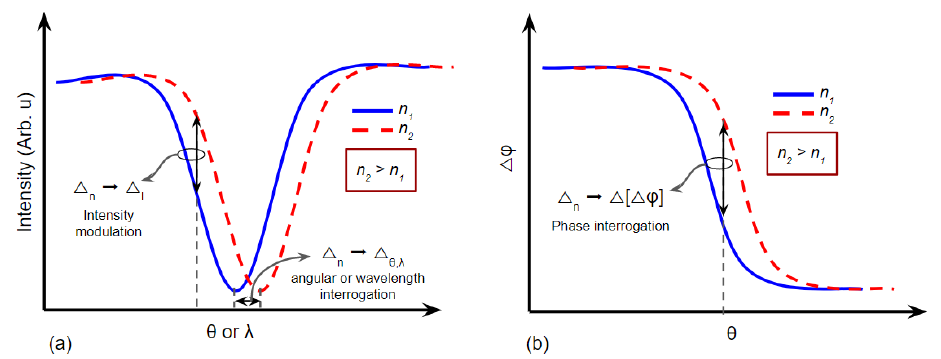
Figure 8. The methodology of SPR measurement ( a ) principle of intensity, angular, and wavelength interrogation. ( b ) The principle of phase interrogation method for SPR signal acquisition.